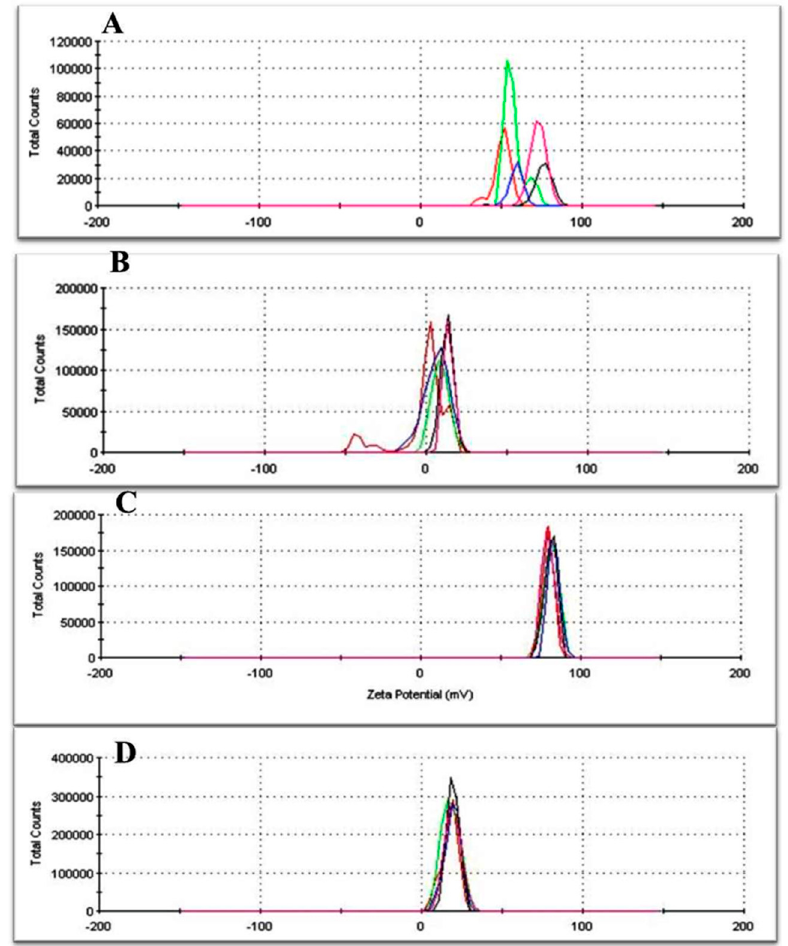
Figure 2. Zeta potential measurement: ( A ) chitosan solution alone; ( B ) oleic acid suspension alone; ( C ) chitosan grafted oleic acid; and ( D ) Hybrid Polymeric Lipid Protein Nanocarriers (HPLPNCs).